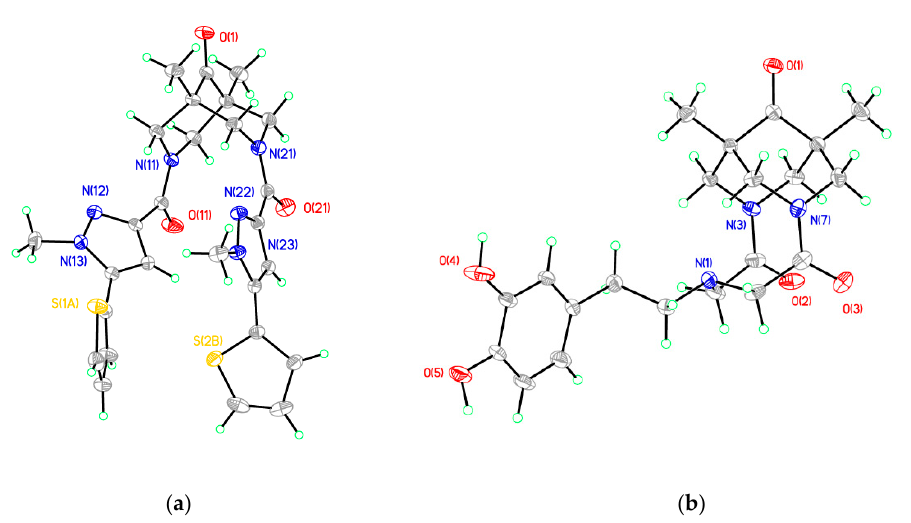
Figure 2. Molecular structures of 1i ( a ) and 3 ( b ). Thermal ellipsoids are shown at a 50% probability level.